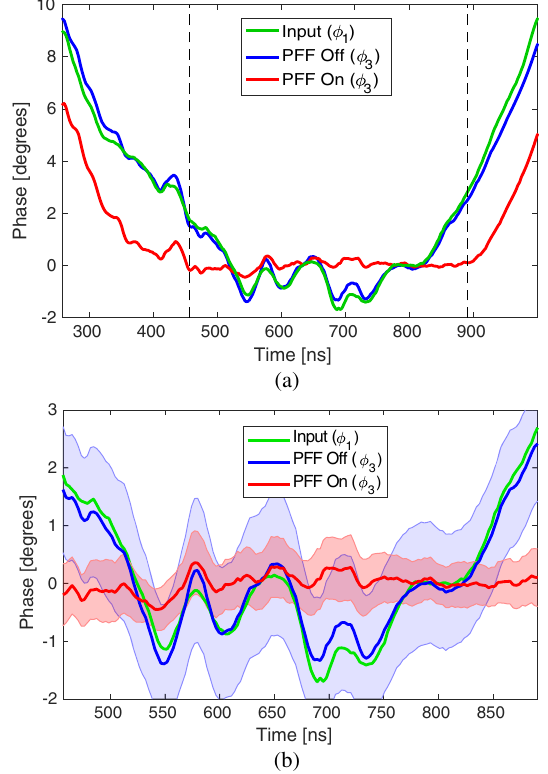
FIG. 5. Correction of the pulse shape with the PFF system. Shown are: the incoming phase ( ϕ 1 ) measured in M 1 (green), and the downstream phase ( ϕ 3 ) measured in M 3 with PFF off (blue) and PFF on (red). Each trace is the average over a 30 minute dataset. (a) The whole beam pulse. Vertical dashed lines mark the time interval corresponding to the PFF dynamic range. (b) The same data zoomed in to the central portion of the pulse. Shaded areas represent the phase jitter at each sample point.